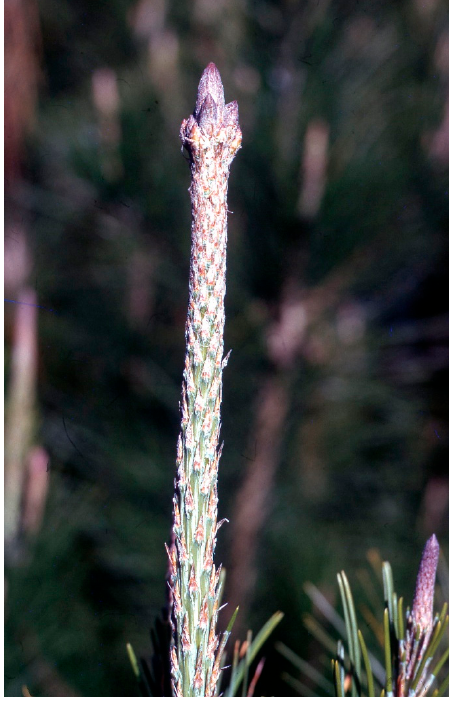
Figure 5. Graft of P. radiata , showing tip of leader during autumn with well-developed “basal flush” [44] subtending compound sealed bud containing lateral buds at tip (Scion Image Library). In P. radiata , maturation progresses more gradually than in most pines [32,34], alt-